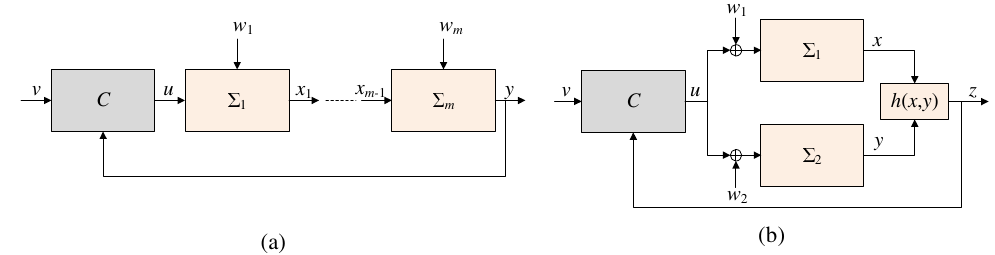
Figure 4. Corrective control system for composite ASMs: ( a ) serially connected ASM and ( b ) parallel connected ASM.